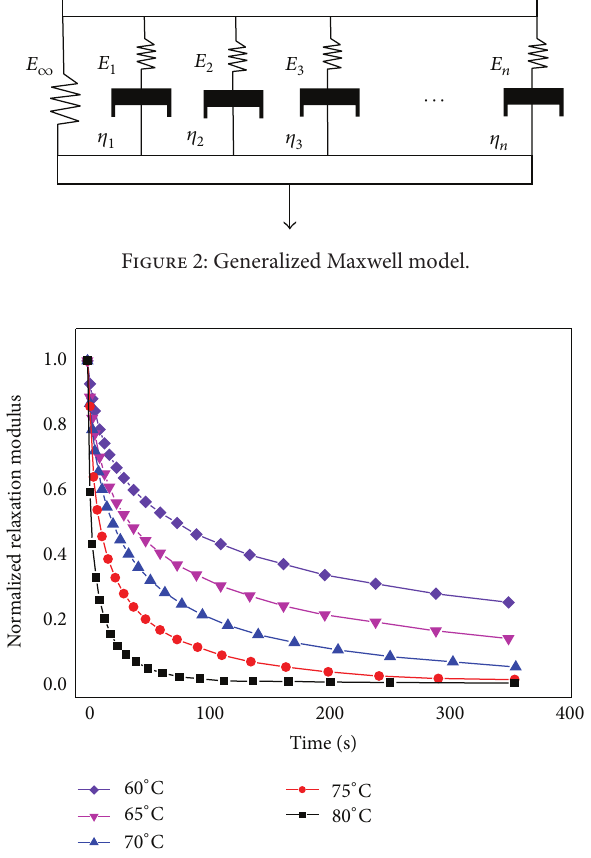
Figure 3: Normalized relaxation modulus curves of PLGA (50/50) with different temperatures.